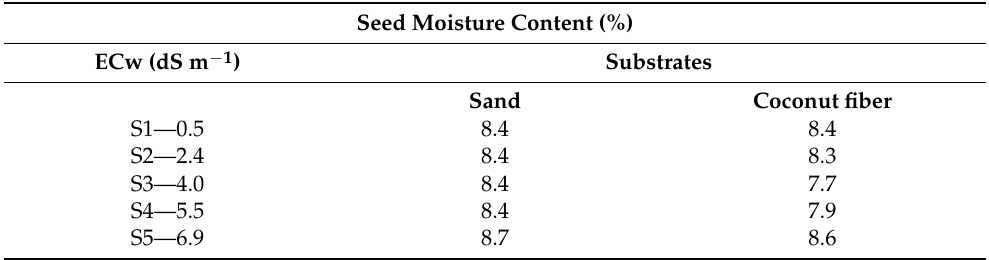
Table 1. The initial moisture content of mini watermelon seeds is produced with reject brine (ECw) and substrates. Seed Moisture Content (%) ECw (dS m − 1 ) Substrates Sand Coconut